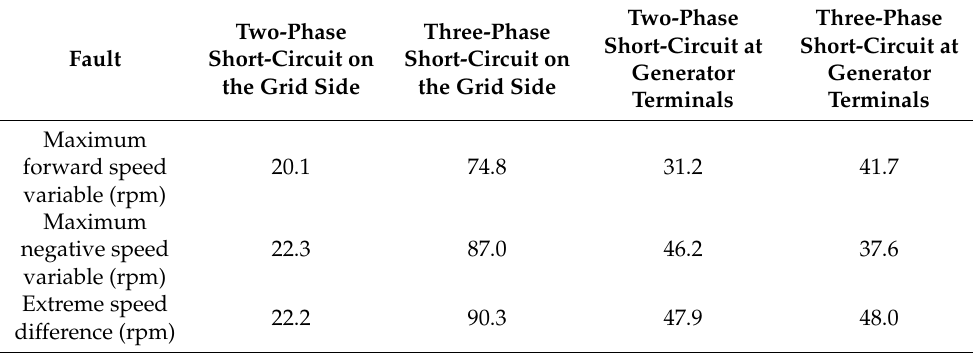
Table 6. Known value under 80% load of